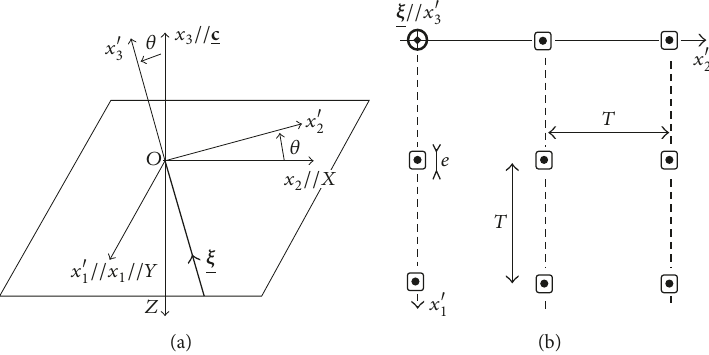
Figure 1: Cartesian frames and symbols attached to (a) an isolated inclined threading dislocation (TD) oriented by 𝜉 // 𝑂𝑥 󸀠 3 in the plane 𝑂𝑥 2 𝑥 3 and (b), two infinite sets of periodically distributed TDs oriented along 𝜉 . Each of these TDs has a cylindrical core, the section of which is a small